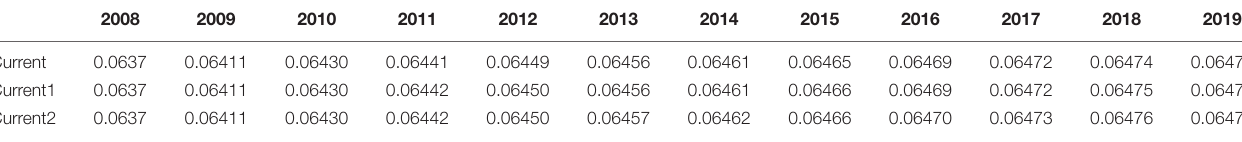
TABLE 5 | Influence of innovation input on the network collaborative efficiency of the macro manufacturing